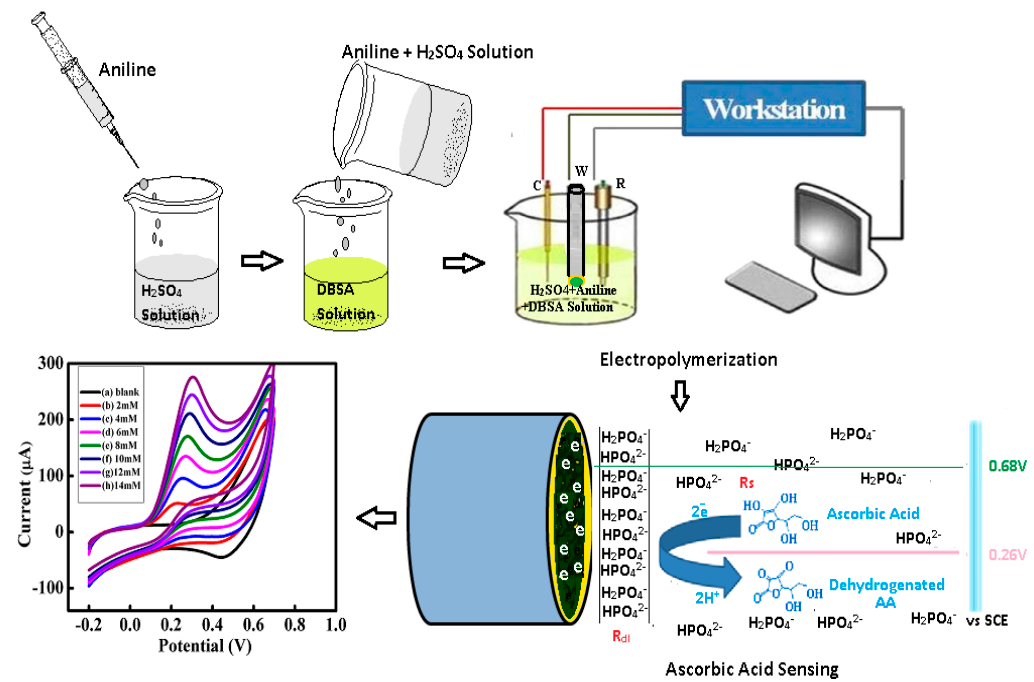
Scheme 1. Schematic representation of polyaniline (PANI) electrode preparation and electrochemical oxidation of ascorbic acid (AA). Dodecylbenzene sulfonic acid (DBSA).